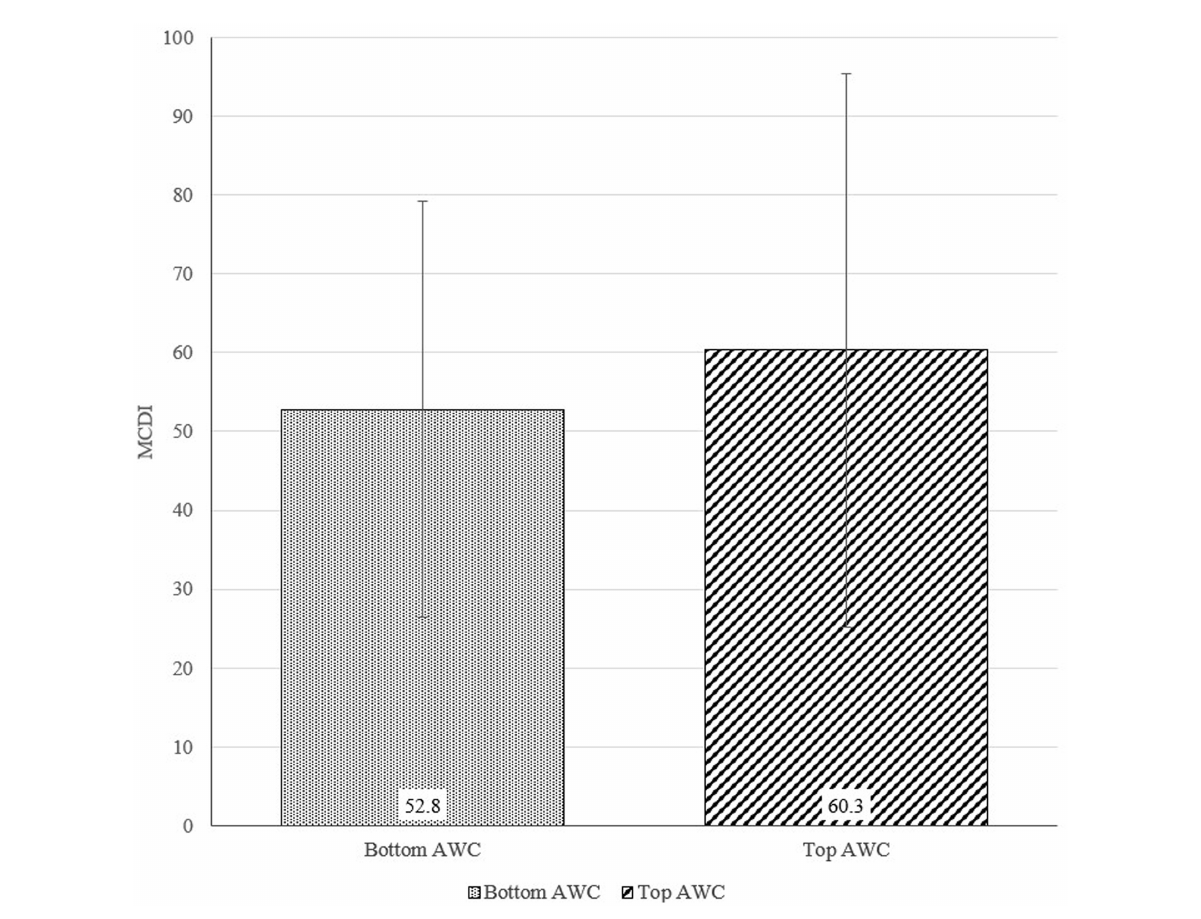
FIGURE 6 Differences in MacArthur-Bates Communicative Development Inventories (MCDI) scores between top and bottom terciles of Adult Word Count (AWC; p -value =